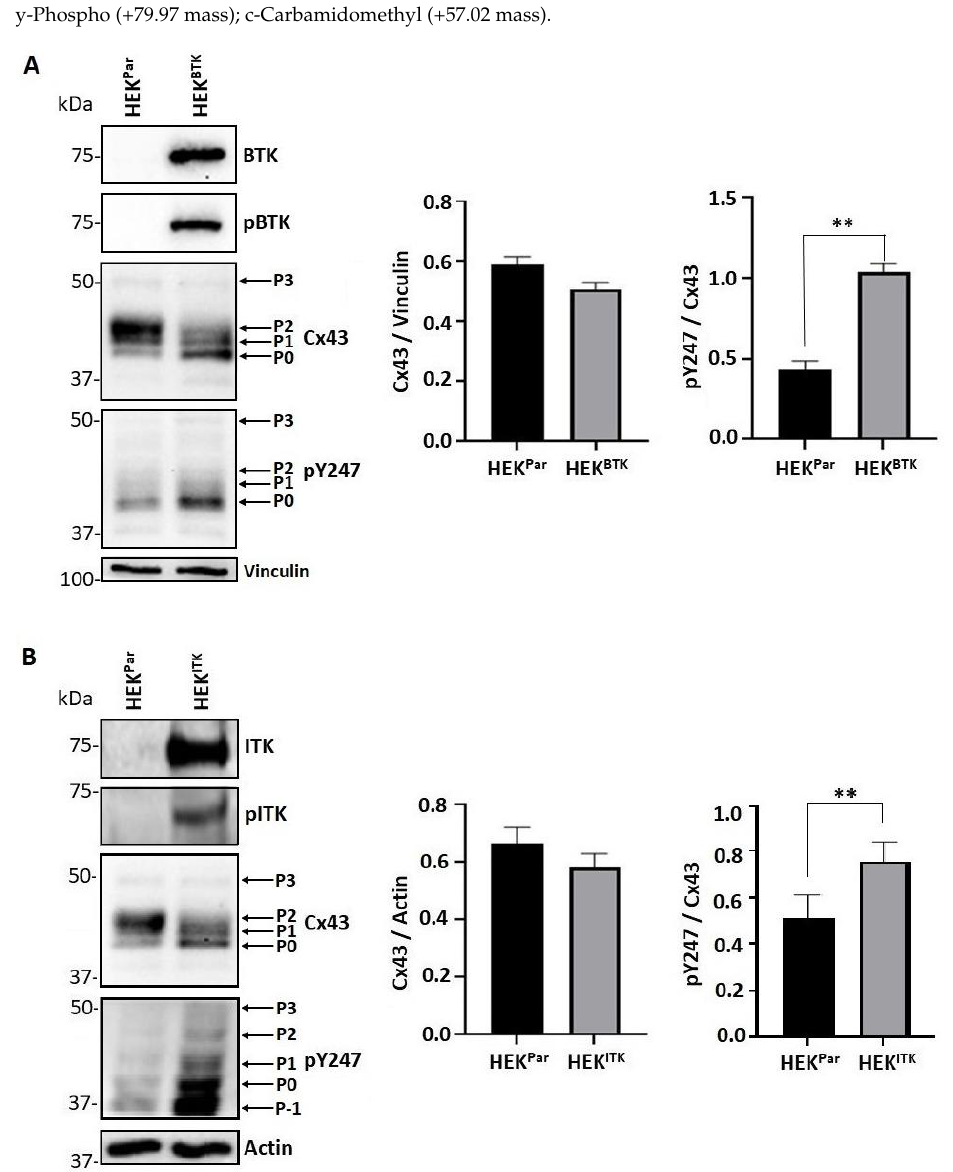
Figure 3. Effect of BTK and ITK phosphorylation on Cx43 regulation in the HEK-293T cells as ob- served through changes in electrophoretic mobility. Western blot of HEK-293T parental (HEK Par ) and ( A ) stably expressing BTK (HEK BTK ) or ( B ) stably expressing ITK (HEK ITK ) cell lysates. Antibodies used are labeled on the right of each blot. Arrows are pointing to the different migrating Cx43 bands from the electrophoresis. Data were quantified using ImageJ (all units were measured in pixels) and GraphPad Prism by the Student’s t -test ( n = 3, ** p < 0.01).